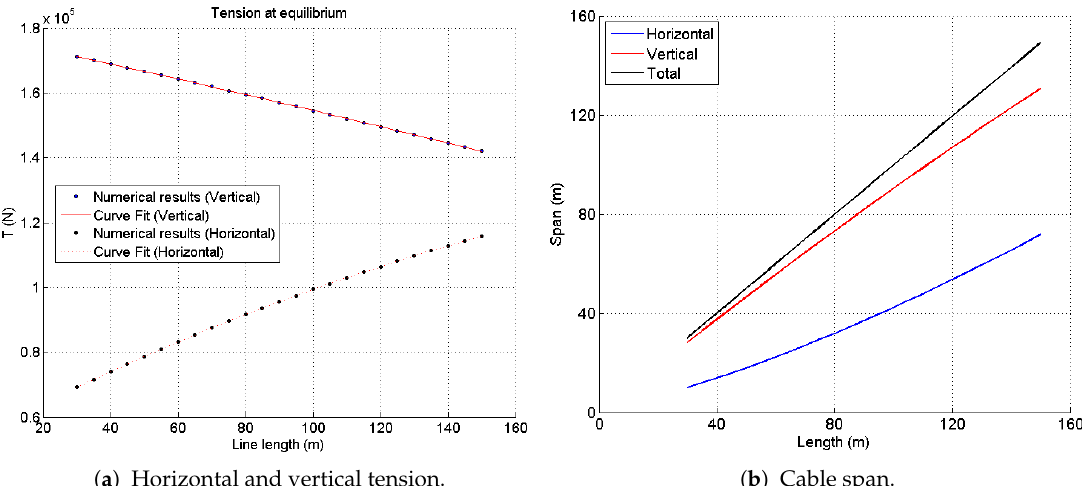
Figure 17. Dependence on the cable